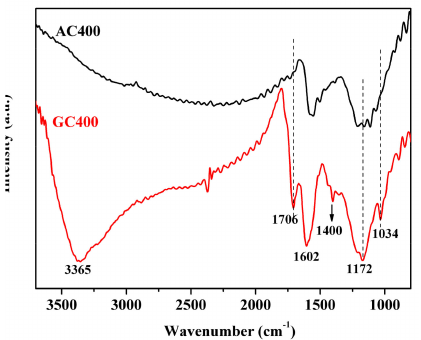
Figure 2. FT-IR results of two sulfonated carbon materials.